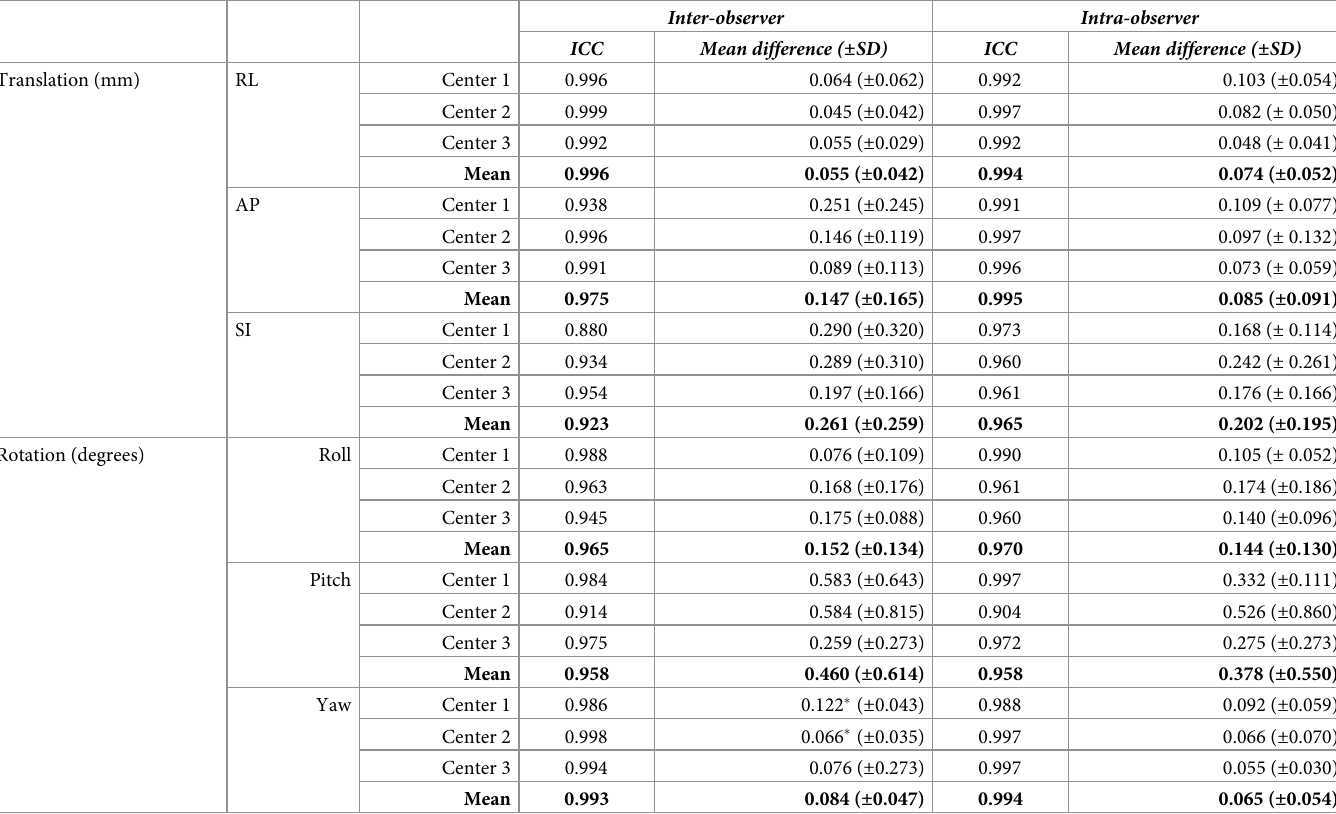
Table 3. Intra-observer and inter-observer intraclass correlation coefficients (ICC) and mean differences for measurements of the maxilla.